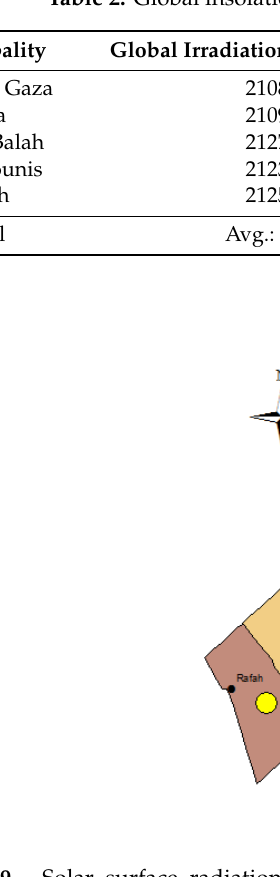
Table 2. Global insolation and solar energy potential in GSs’ municipalities.